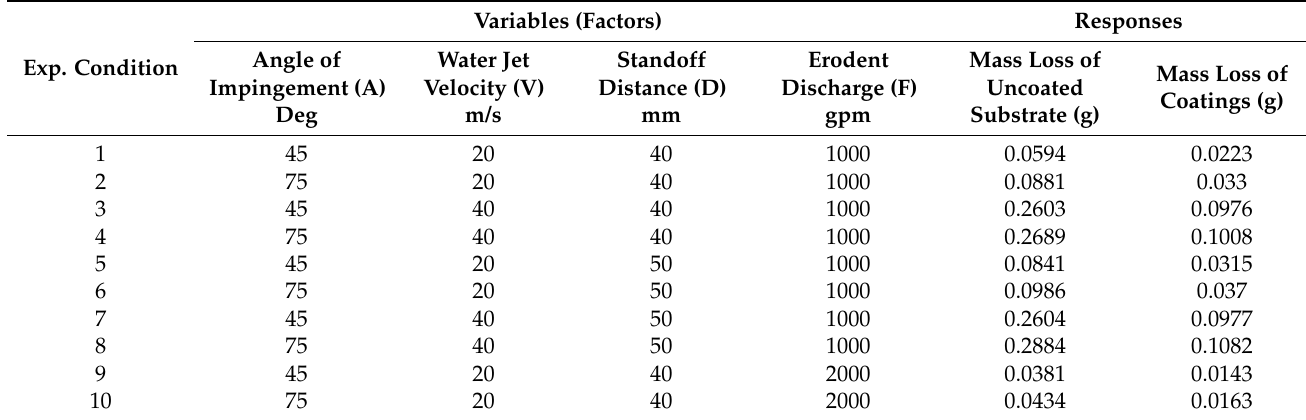
Table 4. Experimental design matrix and